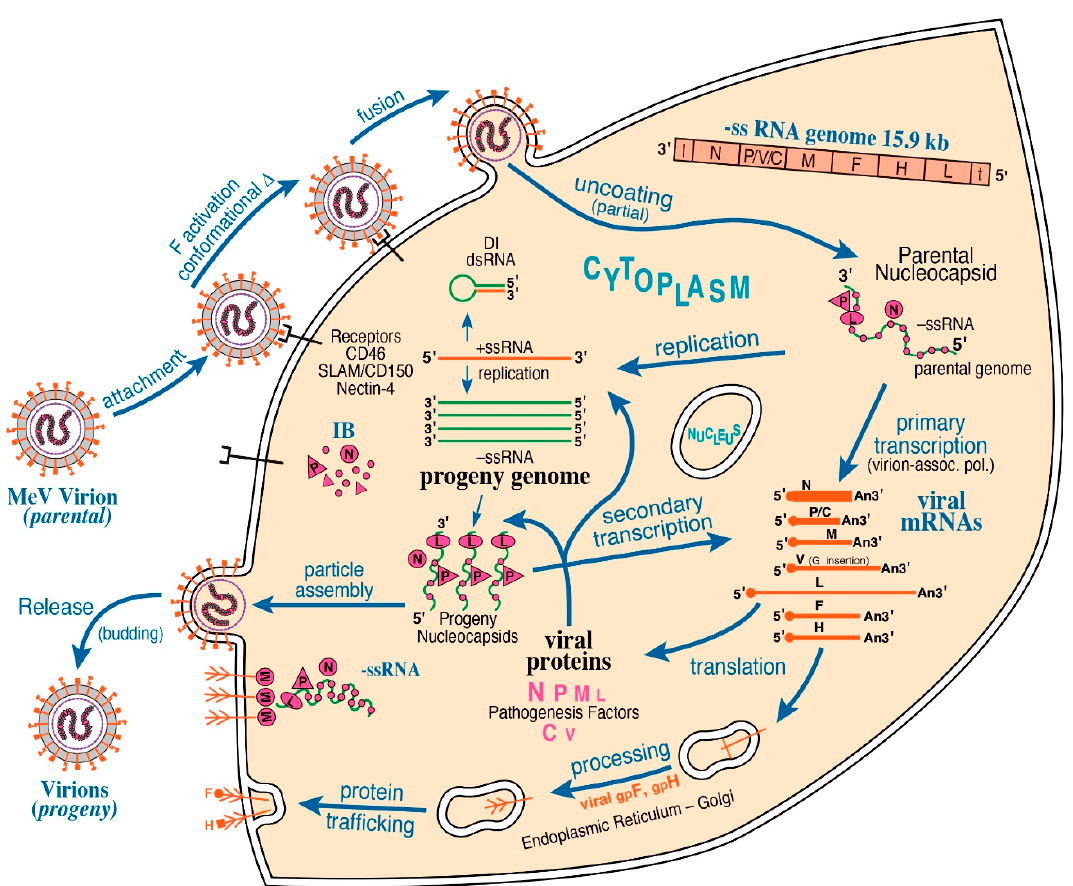
Figure 1. Schematic diagram of measles virus (MeV) multiplication cycle. MeV possesses a negative-sense, single-stranded RNA genome of ~15.9 kb. Virus multiplication occurs in the cytoplasm. Following receptor-mediated virion attachment, the viral envelope fuses with host membranes, releasing the ribonucleocapsid (RNP) complex consisting of genome RNA encapsidated by nucleoprotein N into the cytoplasm; this triggers activation of the virion-associated RNA polymerase complex of viral L and P proteins. The RNP constitutes the basic machinery responsible for RNA synthesis, initially for transcription and then for replication. These processes are thought to be associated with the cytoplasmic inclusion body (IB) factories. Viral C protein interacts with P and enhances polymerase processivity; in the absence of C, defective interfering (DI) RNAs are readily formed. IB assembly triggered by MeV infection is mediated by liquid–liquid phase separation (LLPS). MeV N and P proteins are sufficient to form IB structures by LLPS. The viral matrix M protein mediates assembly of progeny enveloped virions that include two viral glycoproteins, the hemagglutinin H attachment protein and the F fusion protein.